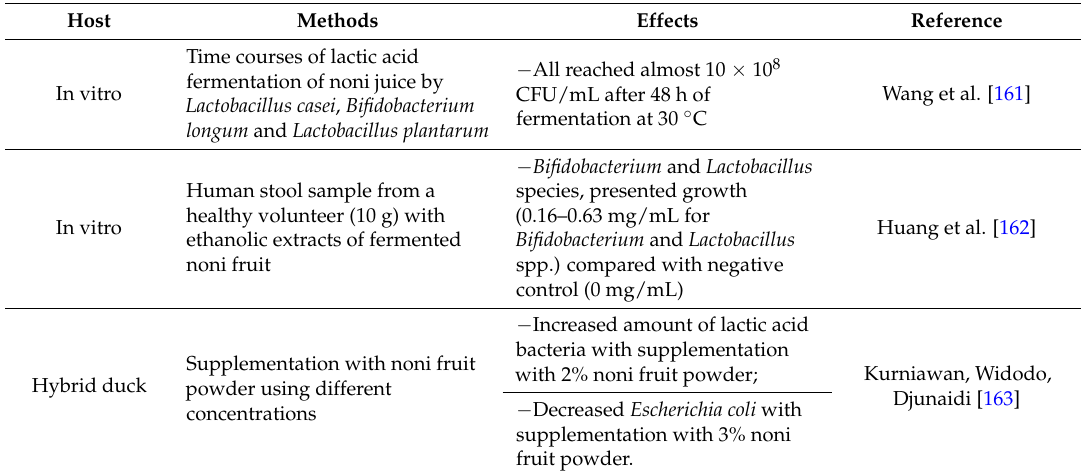
Table 7. Effects of administration of Morinda citrifolia L. on gut